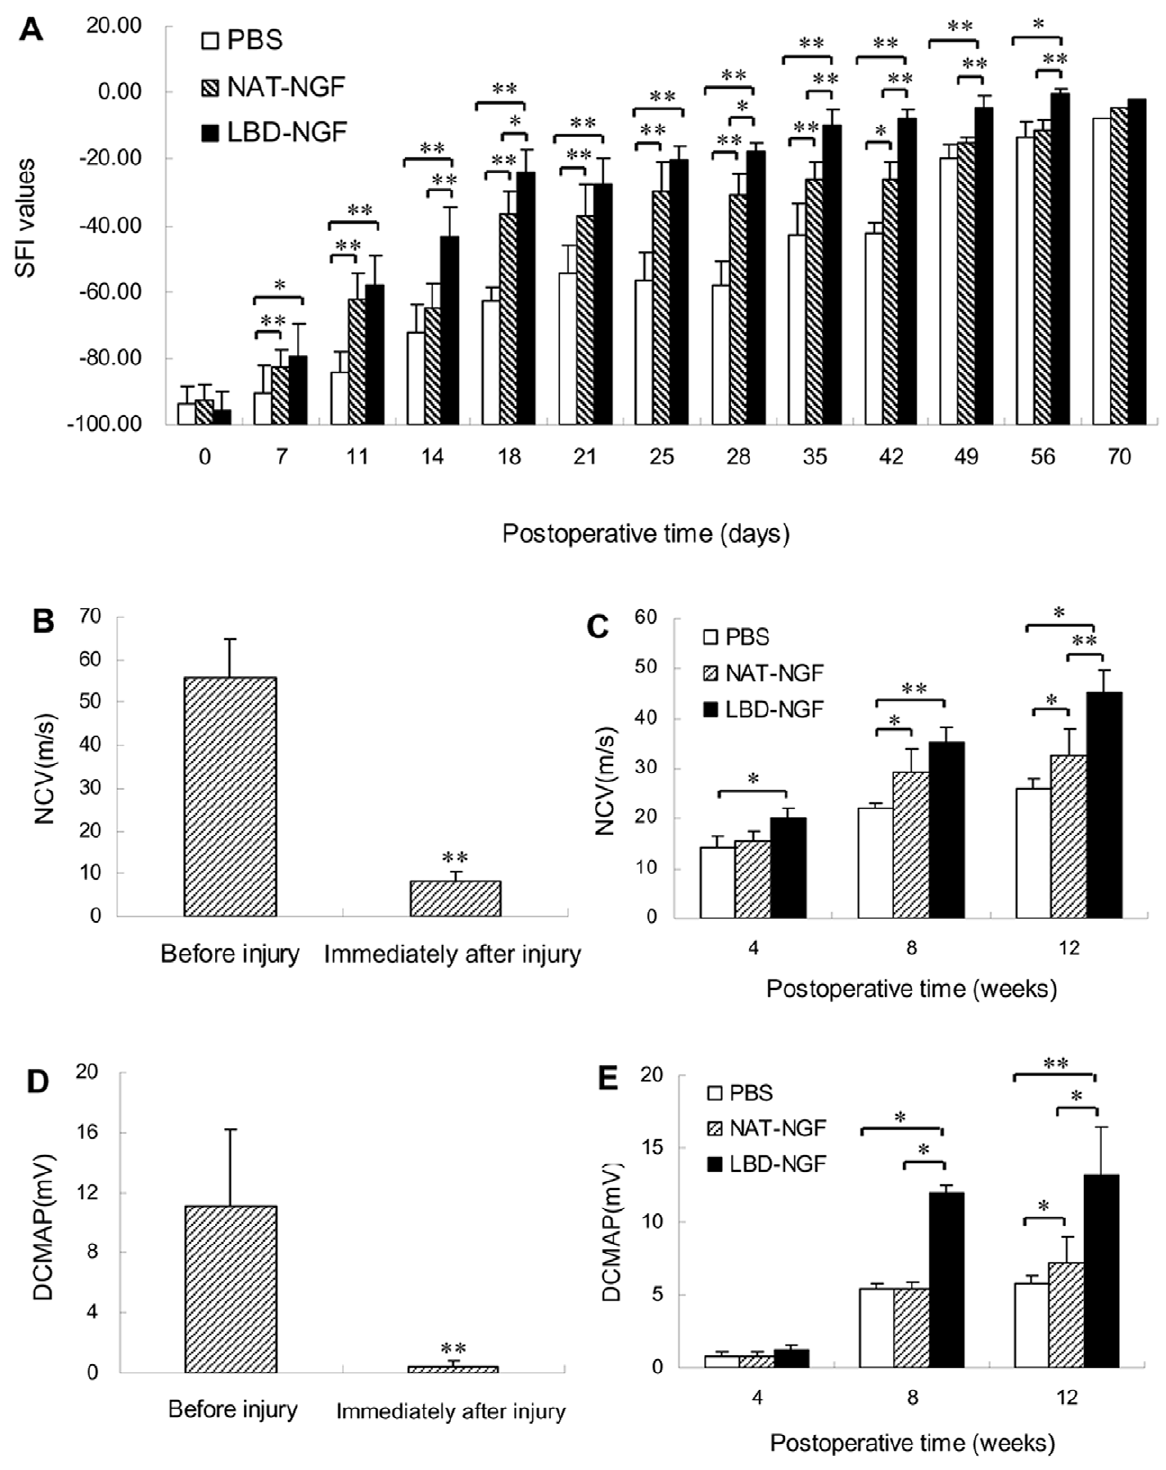
Figure 4. Functional recovery after sciatic nerve injury. (a) Measurements made from walking track prints were then submitted to SFI. (b) NCV evaluation before and immediately after sciatic nerve injury. (c) NCV evaluation at weeks 4, 8 12 after the sciatic nerve injury. (d) DCMAP evaluation before and immediately after sciatic nerve injury. (e) DCMAP evaluation at weeks 4, 8 12 after the sciatic nerve injury. n=6, *, P , 0.05, **, P , 0.01, determined by two-tailed student’s t -test.